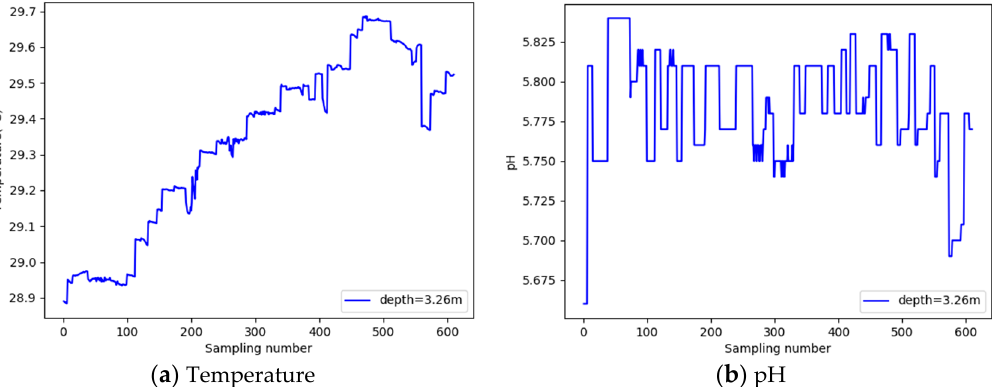
Figure 2. Water quality parameters vary with the number of samples.